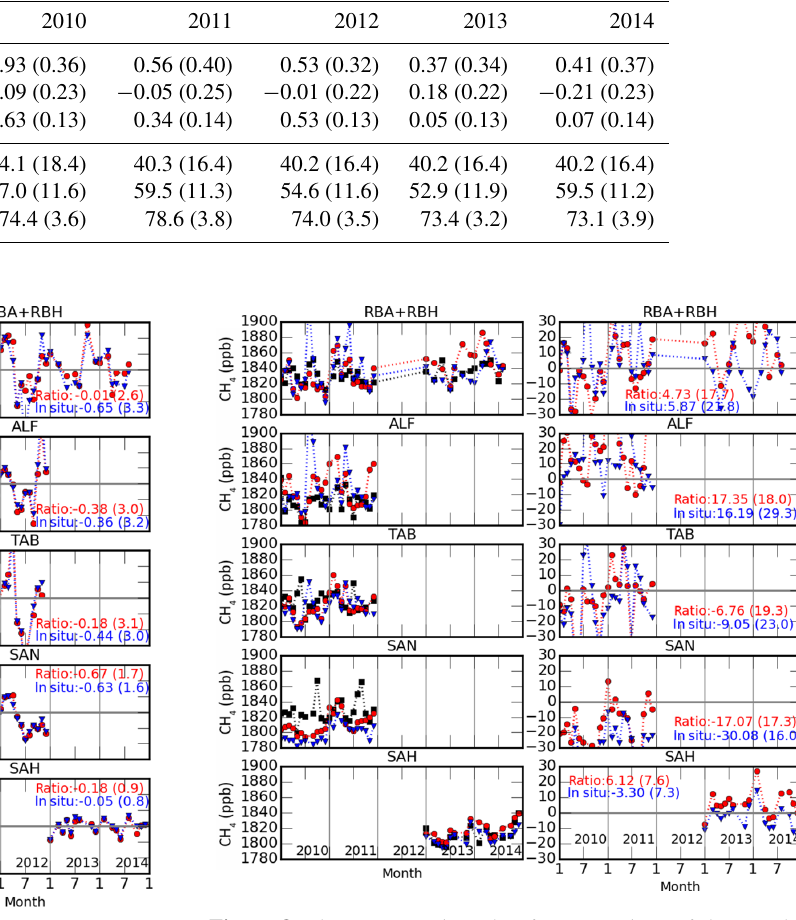
Figure 8. The same as Fig. 7 but for comparison of the monthly mean partial CH 4 columns (in ppb) of the model simulations with AMAZONICA and ACO observations. Due to availability, CH 4 ob- servations for 2012 have not been